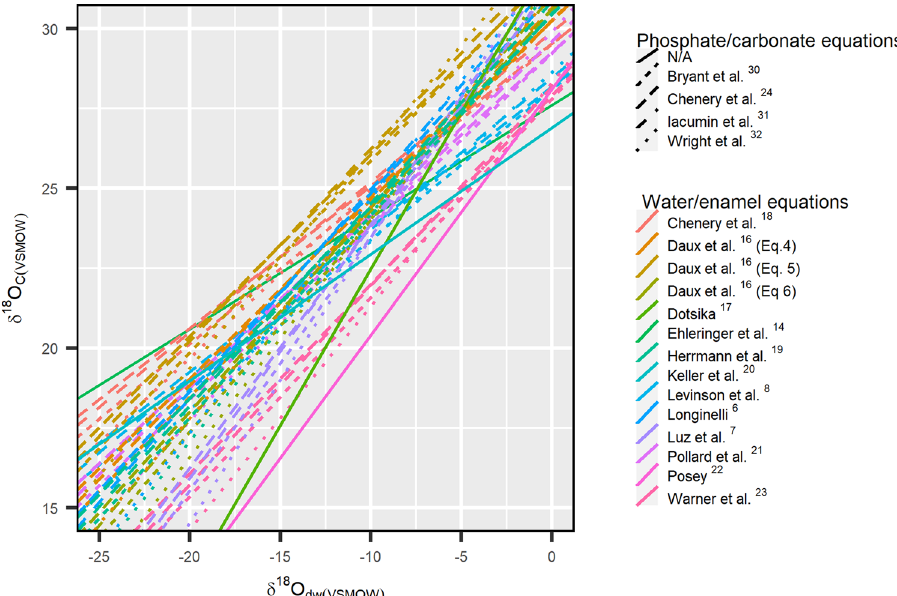
Figure 1. Existing water/enamel conversion equations are shown as the relationship between drinking water oxygen values ( δ 18 O dw ) and enamel carbonate oxygen values ( δ 18 O C(VSMOW) ). This graph aims to provide a visual representation of the various water/enamel conversion equations that exist to date and to show the general spread of slopes and intercepts, rather than for interpretation. Phosphate/carbonate conversion equations were applied to water/enamel equations based on enamel phosphate oxygen. Solid lines indicate the equations that allowed for direct conversions between δ 18 O dw and δ 18 O C(VSMOW) values without requiring the use of an additional phosphate/carbonate conversion. The linetypes indicate the use of different phosphate/carbonate conversion